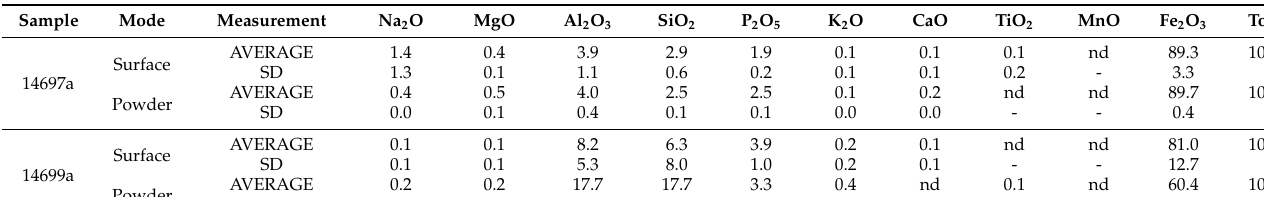
Figure 3. SEM images (BSE, back scattered electron mode) of the surface of two geological pieces studied, showing the coarse inclusions in one shale (14050b) and the matrix of iron oxide crystals in one ferricrete (14697a).